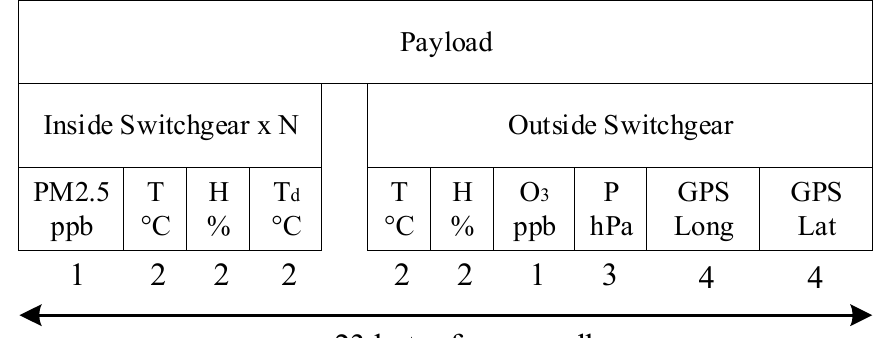
Figure 8. The payload needed for one cell .